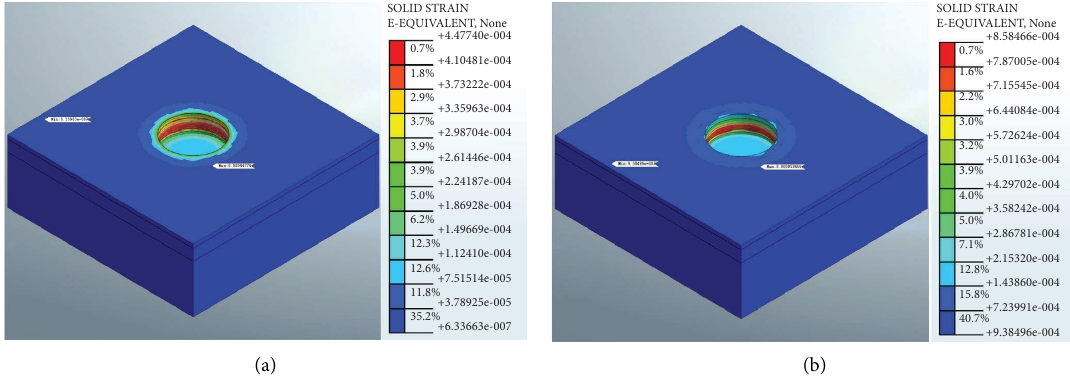
Figure 18: Working condition 9. Equivalent soil strain (a) without pore water pressure and (b) with pore water pressure applied.